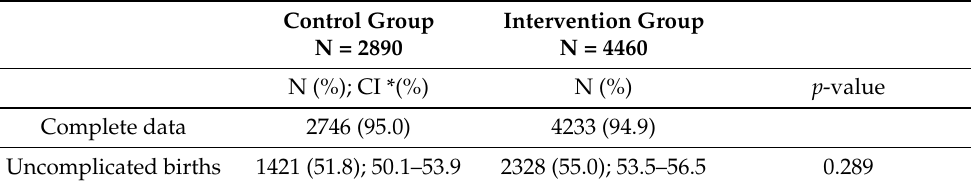
>90% of the registered women (Table 2). Table 2. Uncomplicated